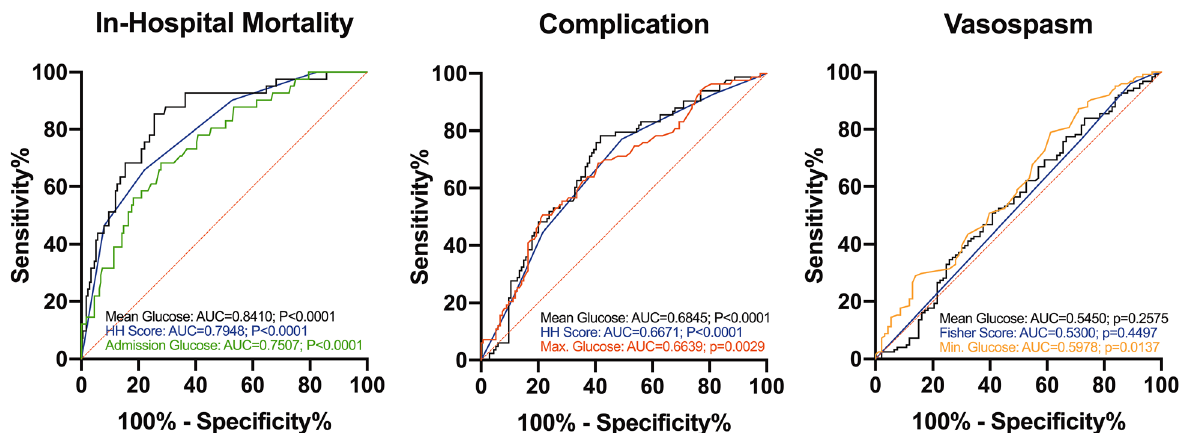
Figure 3. Receiver operating characteristic (ROC) curves for predicting in-hospital mortality (left), complications (middle), and vasospasm (right). Variables with corresponding area under the curve (AUC) are shown for the two glycemic variables with the highest significance. HH (left, middle) or Fisher score (right) are plotted for